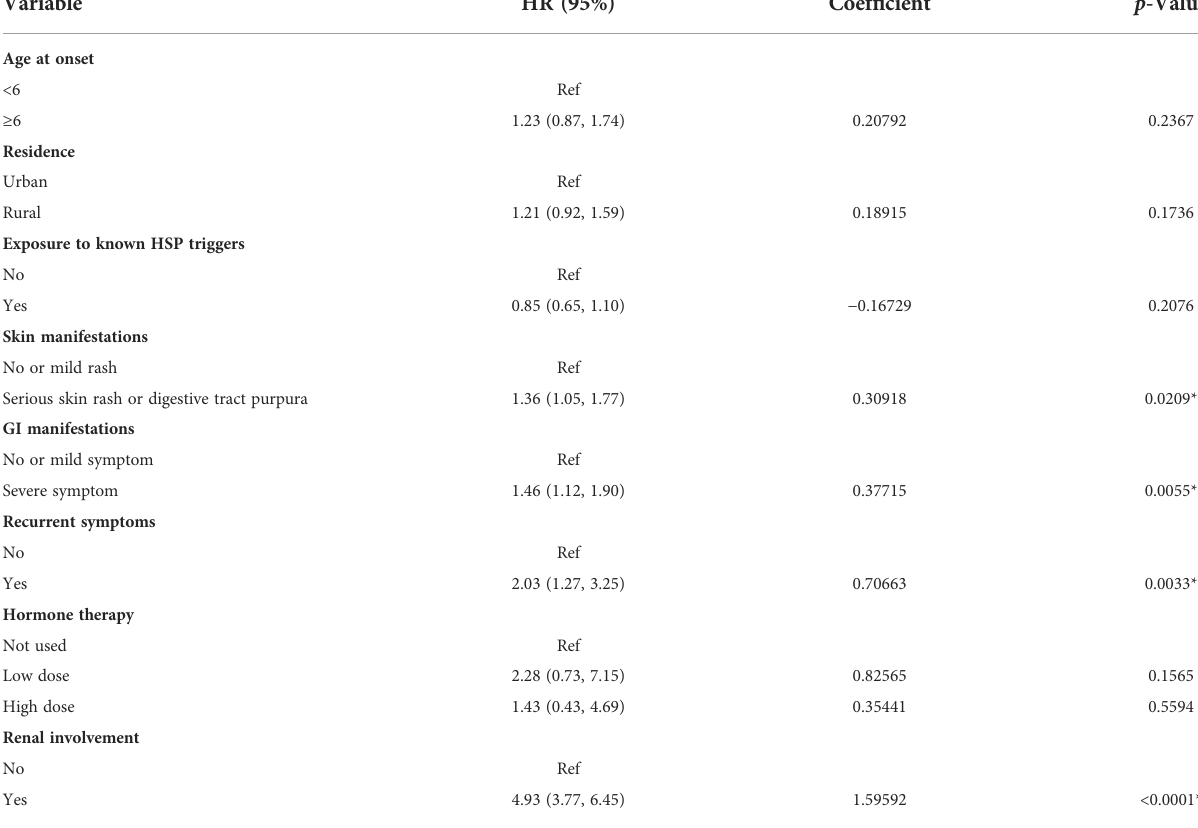
TABLE 2 Multivariate Cox regression analysis in training